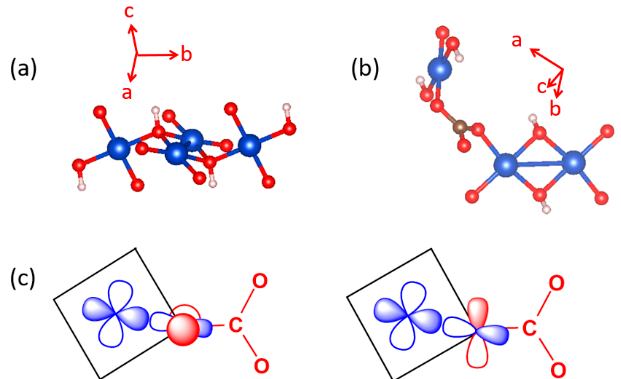
Figure 21. ( a ) A diamond unit of Azurite. ( b ) Arrangement of the CuO 4 monomer and Cu 2 O 6 dimer associated with the spin exchange path J 4 . ( c ) Interaction of the O p π and O p σ orbitals of the CO 32 − ion with the p-orbital tail of the Cu 2+ ion magnetic orbital.